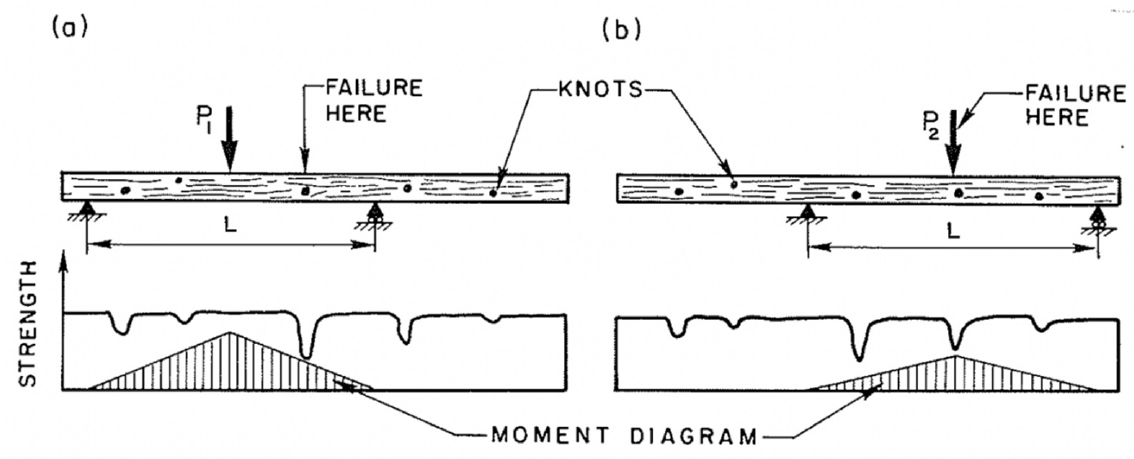
Figure 16. Schematic diagram showing how a wooden beam containing knots can fail at a different place from where it is loaded. From [102]. ( a ) Failure occurs away from peak load due to a weak knot close by. ( b ) Failure occurs at peak load as the peak load coincides with a knot, even though that knot is stronger than that shown in ( a ).